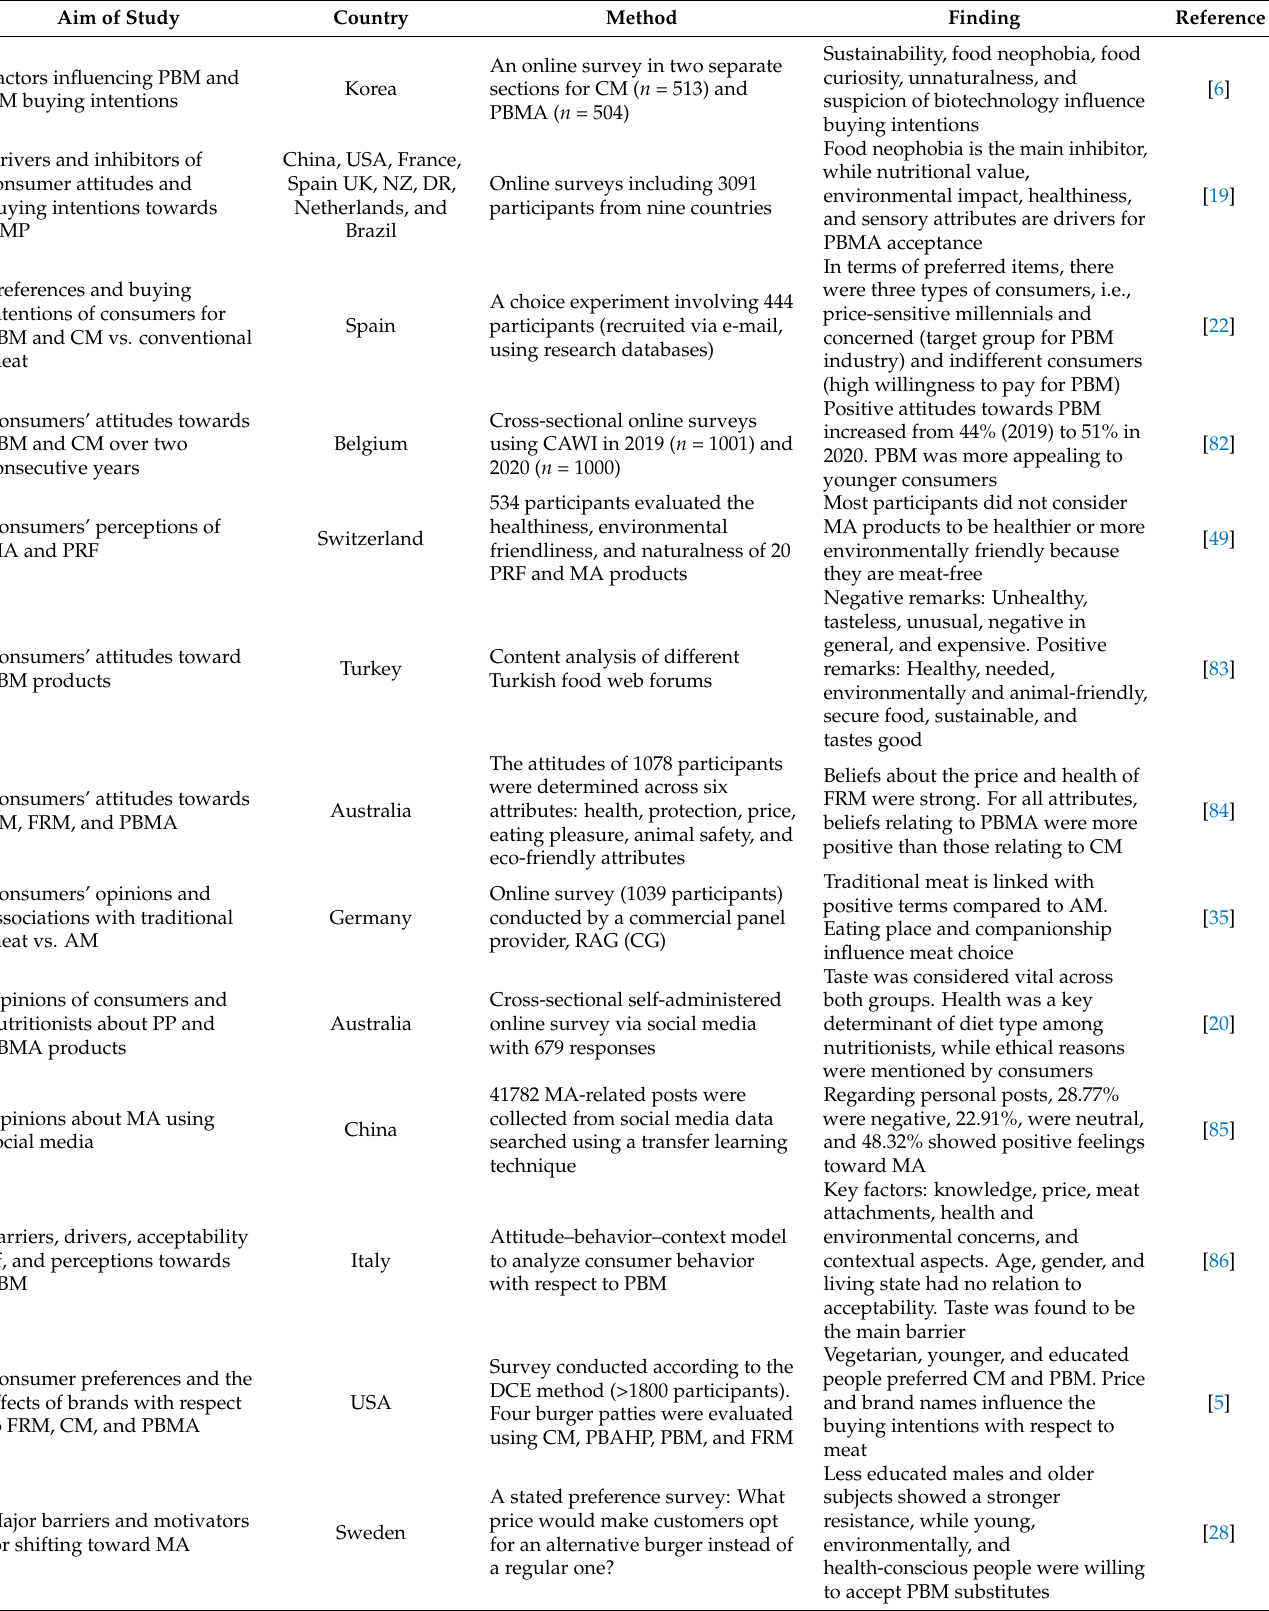
Table 2. Overview of studies aiming to understand the acceptance and perceptions of plant-based meat in different